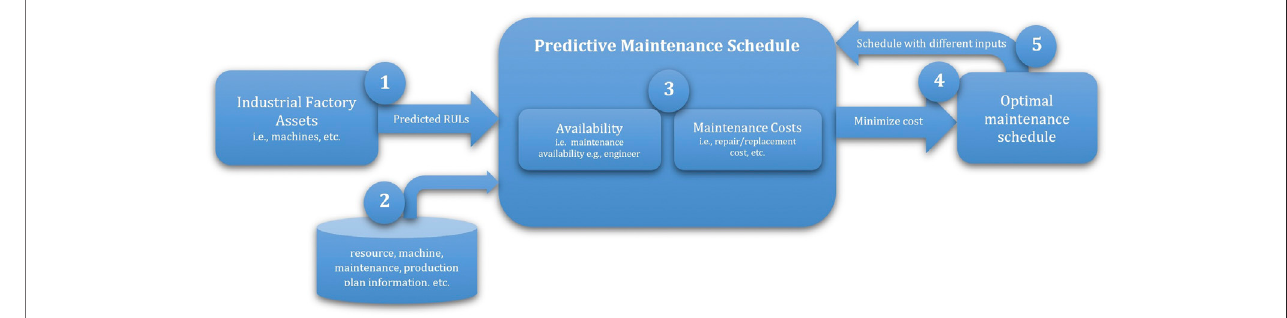
FIGURE 6 | Overall predictive maintenance schedule